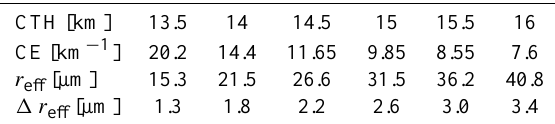
Fig. A4. Cloud top temperature observed by the MODIS instru- ment. In the area of interest (black circle 61.64 ◦ W 16.19 ◦ N) the cloud top temperature drops to ≈ 200K Where N is the number density of cloud droplets, and ρ =0.918gcm − 3 the ice mass density. The cloud water con- tent w can be retrieved from the cloud water measurement.